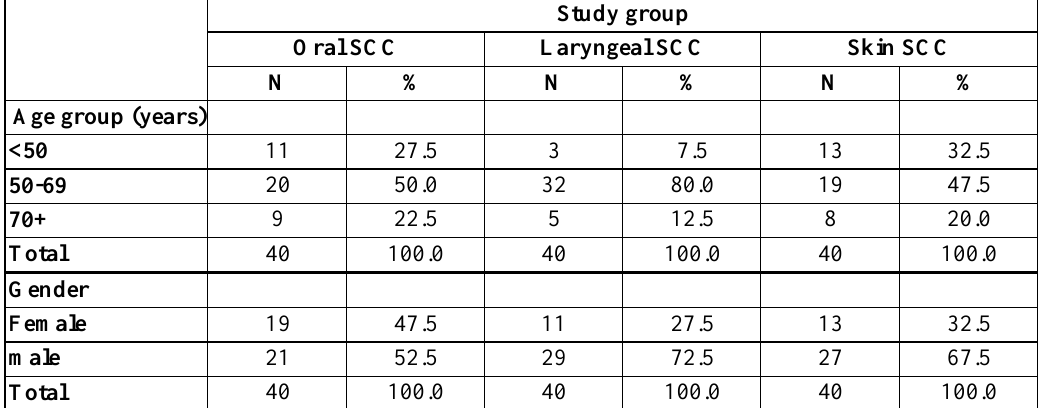
Table 1: Frequency distribution of the study groups by age and gender